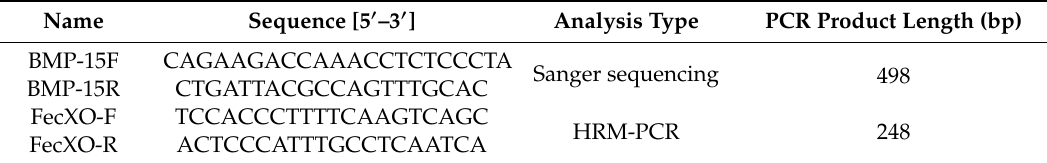
Table 1. Primers used in Sanger sequencing and HRM